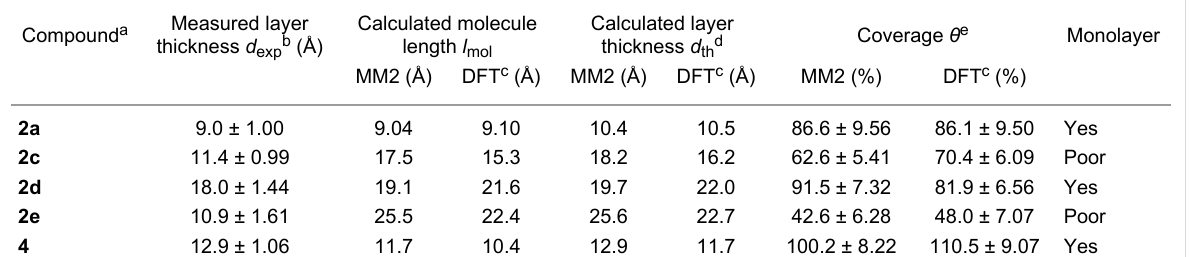
Table 2: Measured (ellipsometry) and calculated (MM2, DFT) layer thickness of (oligo)phenothiazinyl thioacetates 2a , 2c–e , and 4 on Au{111}-coated silicon wafers. Measured layer Calculated molecule Compound a thickness d expb (Å) length l